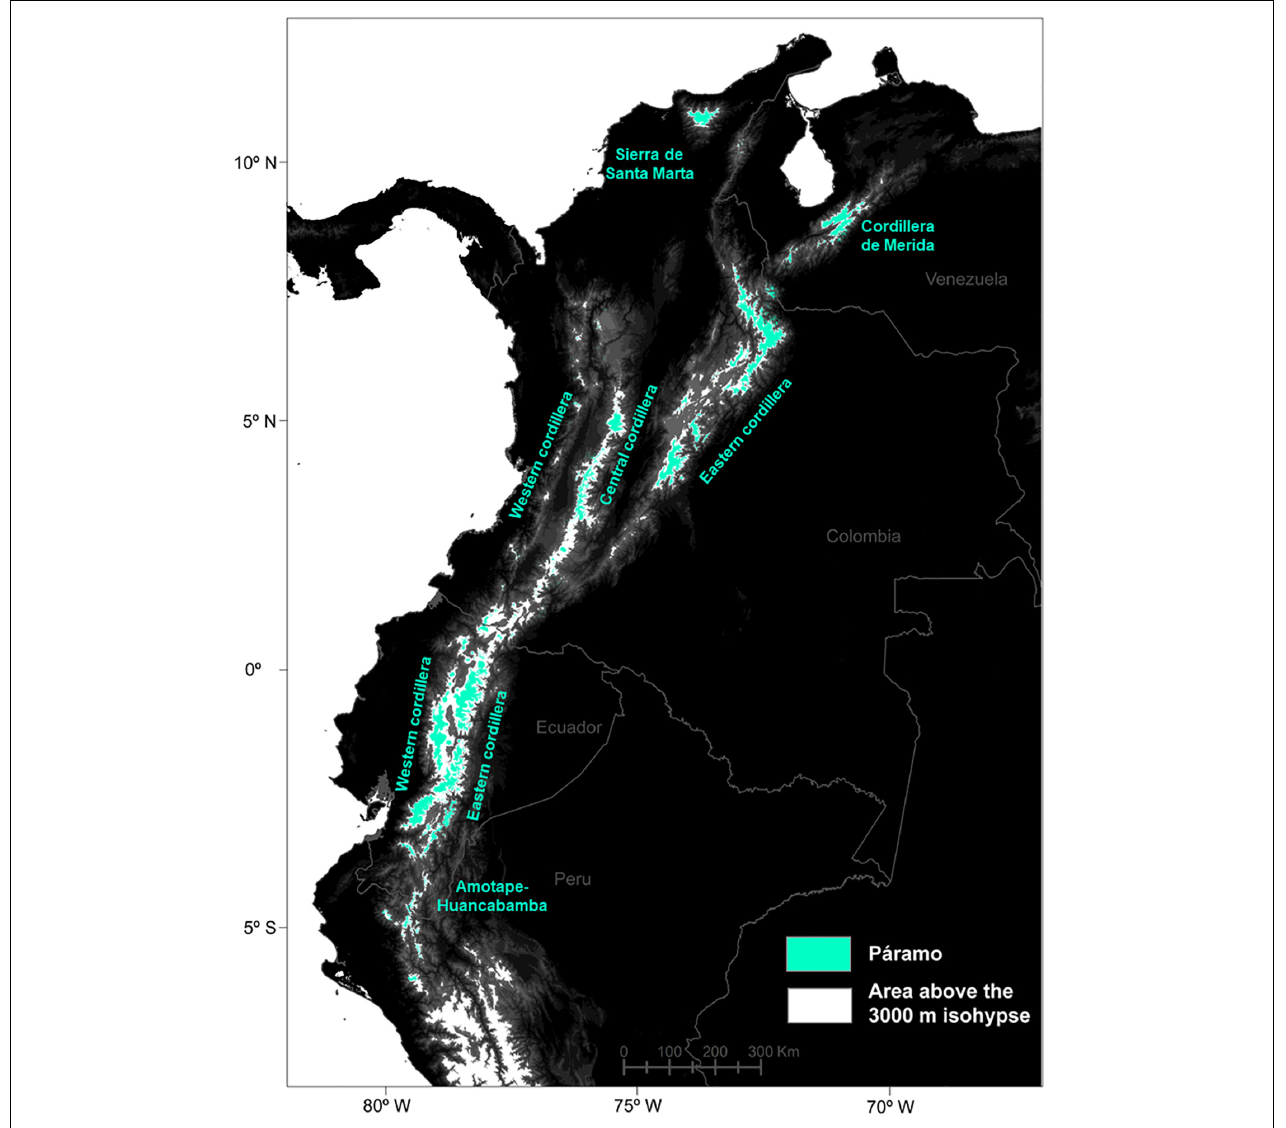
FIGURE 1 | Distribution of the páramo in the Northern Andes (in blue) and delimitation used for the models above the 3,000 m isohypse (in